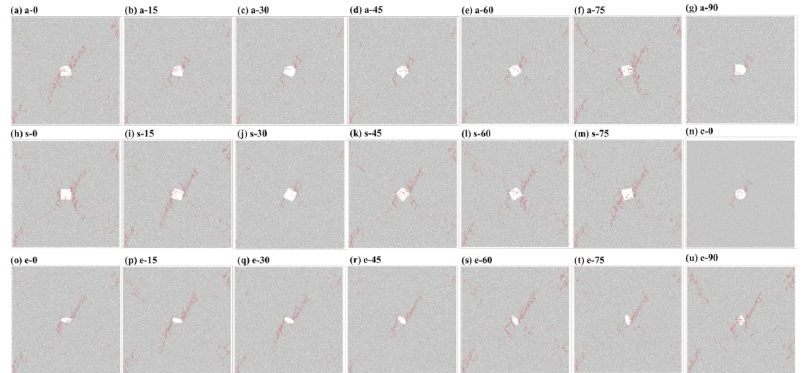
Figure 9. Failure images of pre-holed specimens at the peak stress under coupled biaxial loading and unloading conditions. ( a ) a-0; ( b ) a-15; ( c ) a-30; ( d ) a-45; ( e ) a-60; ( f ) a-75; ( g ) a-90; ( h ) s-0/90; ( i ) s-15; ( j ) s-30; ( k ) s-45; ( l ) s-60; ( m ) s-75; ( n ) c-0; ( o ) e-0; ( p ) e-15; ( q ) e-30; ( r ) e-45; ( s ) e-60; ( t ) e-75; ( u ) e-90.